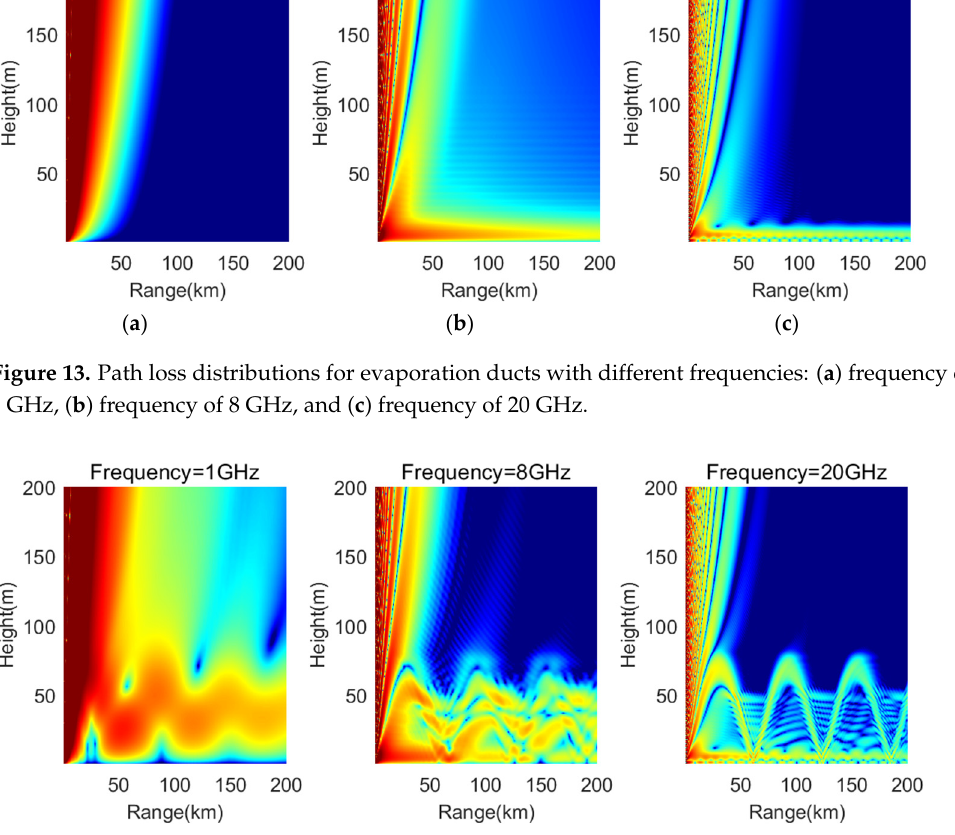
Figure 14. Path loss distributions for hybrid ducts with di ff erent frequencies: ( a ) frequency of 1 GHz, ( b ) frequency of 8 GHz, and ( c ) frequency of 20 GHz.